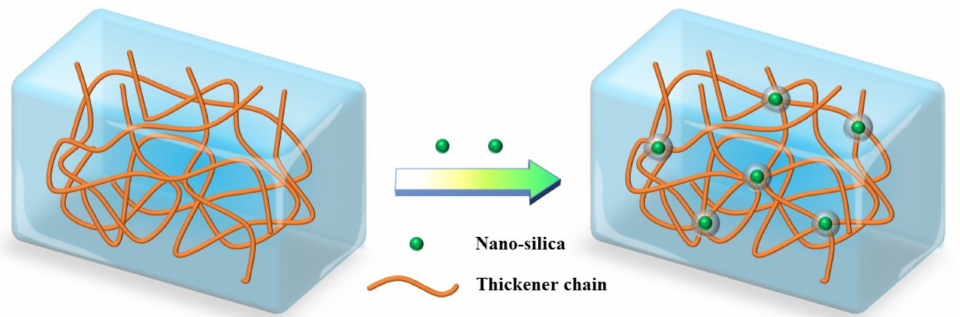
Figure 12. Schematic diagram of the interactions between the thickener matrix and the